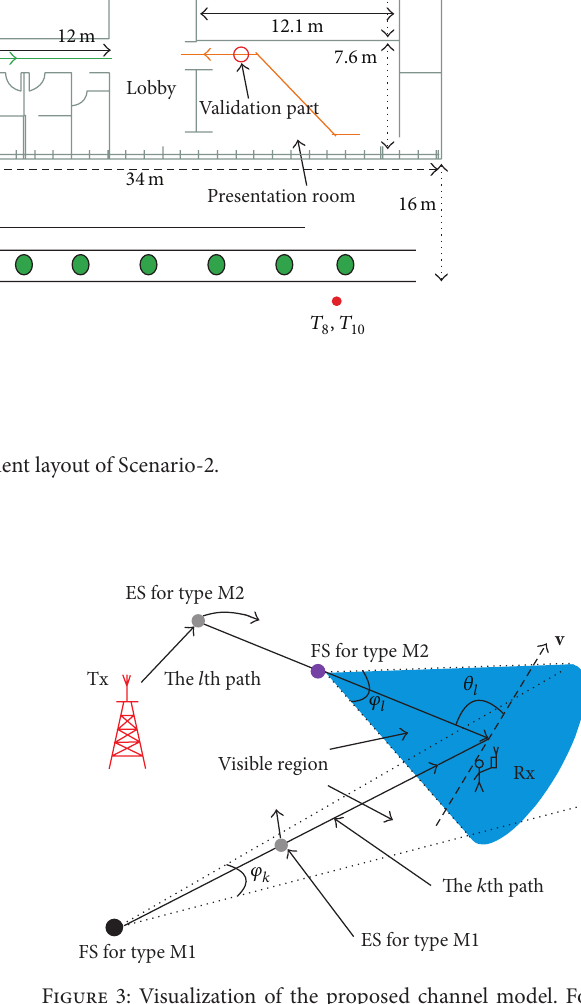
Figure 3: Visualization of the proposed channel model. For rep- resentation convenience, only the MPCs of types M1 and M2 are